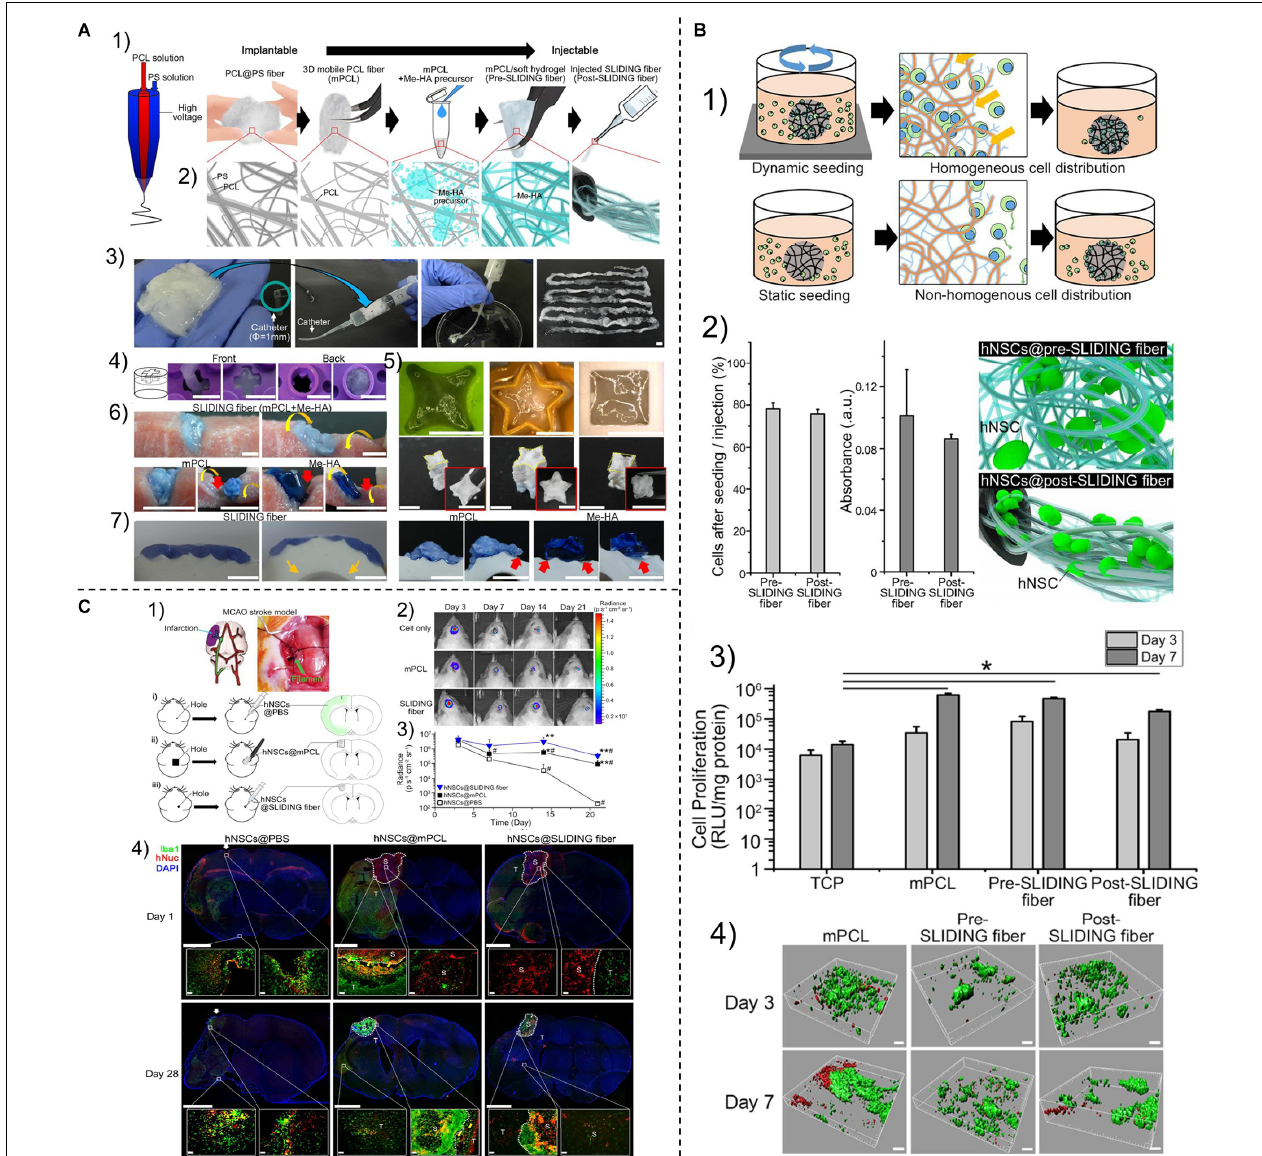
FIGURE 9 | (A) Preparation of sliding fibers and their representative characteristics. (B) In vitro culture of human neural stem cells within sliding fibers. (1) Schematic diagram showing differences in cell seeding methods. (2) Percentage (left panel) and activity (middle panel; CCK-8) of cells remaining in fibers before and after sliding. (3) Cell proliferation after 3 and 7 days of culture in each system [i.e., tissue culture plate (TCP), mPCL sponge, and fibers before and after slip]. Cell proliferation was quantified by monitoring the luciferase activity of hNSCs. (4) CLSM images of hNSCs grown within the mPCL, before or 3 or 7 days after sliding. Live and dead hNSCs were stained with FDA (green) and PI (red), respectively, and the distribution of live/dead hNSCs in each system was reconstructed in three dimensions using IMARIS software. (C) Sliding fibers as hNSC carriers in rats with ischemic stroke. (1) Schematic diagram of the preparation of the MCAO stroke model and the route of hNSC administration into the rat brain cavity. (2) Images of light signals emitted by hNSCs expressing active luciferase implanted or injected in the lesion site at 3, 7, 14, and 21 days after treatment. (3) Emitted light intensity within the region of interest ( n = 3) covering the injection or implantation site. (4) Representative images of immunohistological staining for human nucleus (HNuc; red) and microglia-specific protein Iba1 (green). * P < 0.05; ** P < 0.01. Reprinted (adapted) with permission from Lee et al. (2016). Copyright 2016 American Chemical